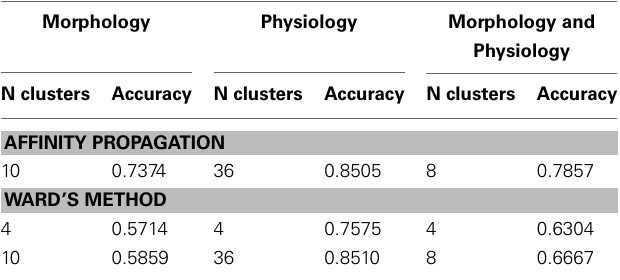
Table 5 | Affinity propagation vs. Ward’s method performance. Morphology